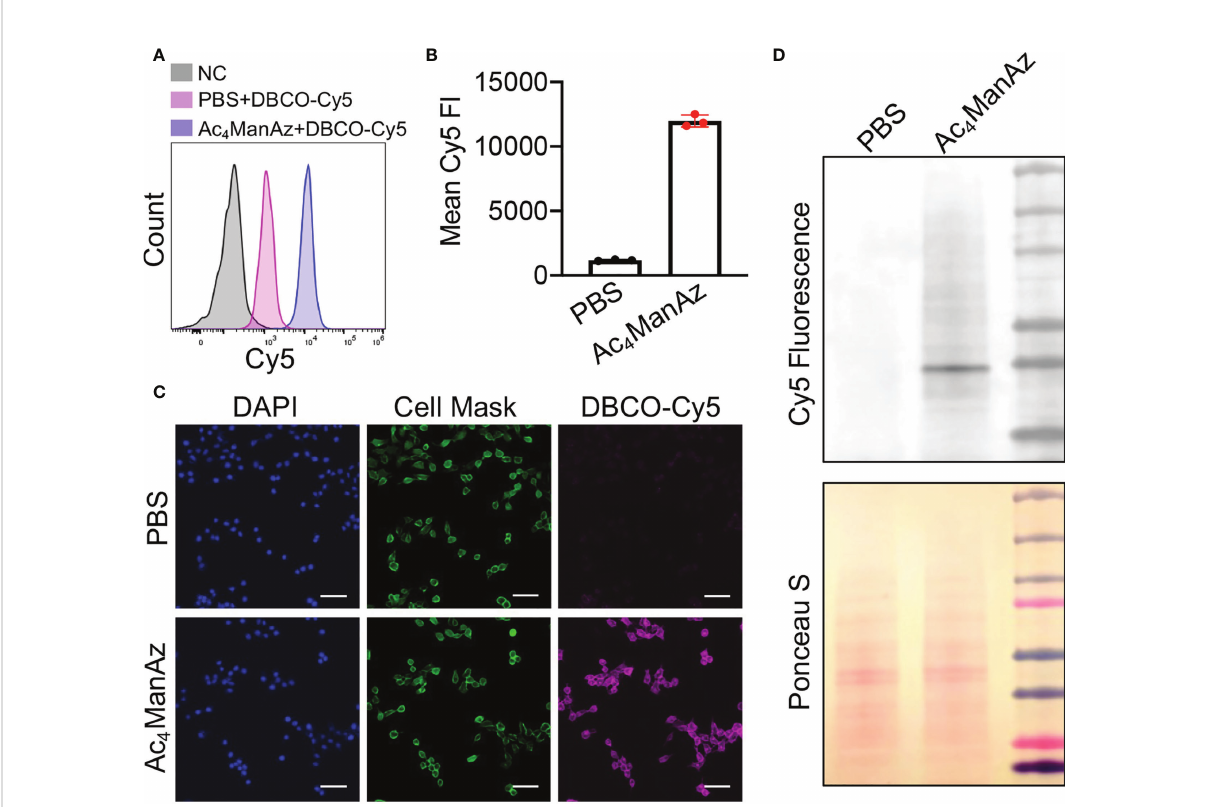
FIGURE 1 Metabolic glycan labeling of 4T1 cancer cells with azido groups. 4T1 cells were incubated with Ac 4 ManNAz (25 m M) or PBS for 48 h, and then stained with DBCO-Cy5 for detection of cell-surface azido groups. (A) Representative Cy5 histograms of 4T1 cells for different groups. 4T1 cells without any treatment were used as negative controls. (B) Mean Cy5 fl uorescence intensity of 4T1 cells pretreated with Ac 4 ManNAz (25 m M) and PBS, respectively. (C) Fluorescence images of Ac 4 ManNAz- or PBS-pretreated 4T1 cells. Cell nuclei and membranes were stained with DAPI and Cell Mask, respectively. Scar bar: 50 m m. (D) Western blot analysis of azido-labeled glycoproteins. Azido-labeled proteins were conjugated with DyLight ™ 650-Phosphine for fl uorescence visualization. Ponceau S stains of whole protein bands were also